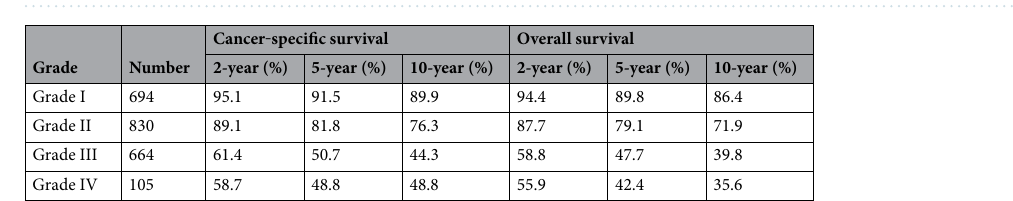
Table 2. The 2-year, 5-year and 10-year survival rates of patients with different tumor grades.